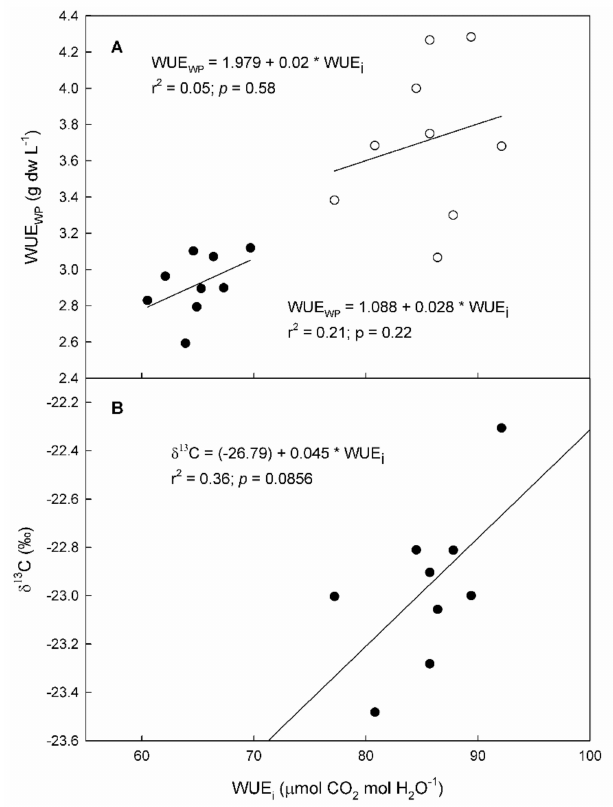
Figure 4. Relationship between intrinsic water use efficiency (WUE i ) and ( A ) whole plant water use efficiency (WUE WP ) and ( B ) carbon isotope ratio ( δ 13 C) measured on 9 “Grenache” genotypes in 2020 (black dots) and 2021 (white